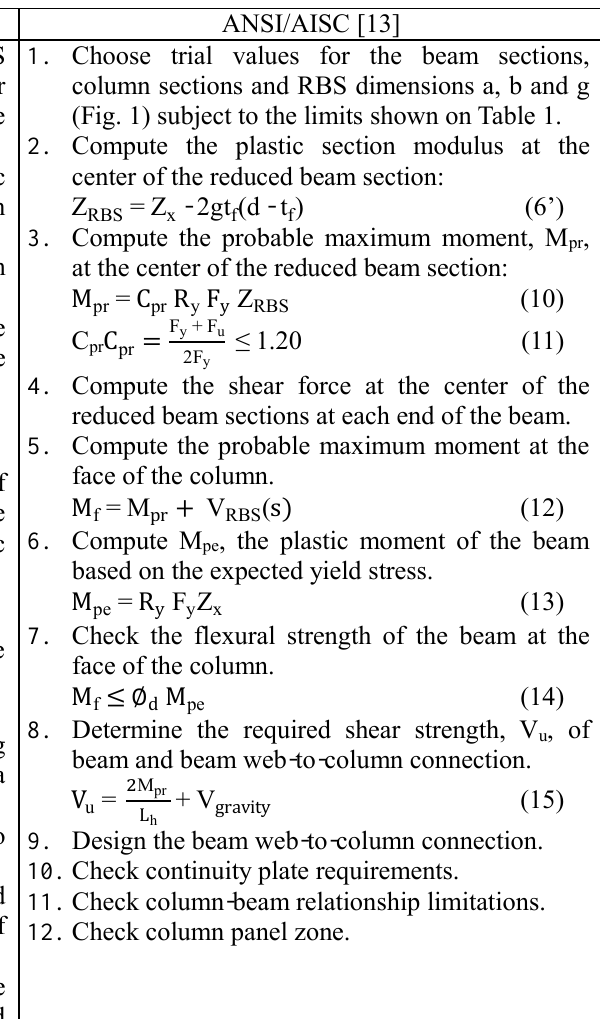
column sections and RBS dimensions a, b and g (Fig. 1) subject to the limits shown on Table